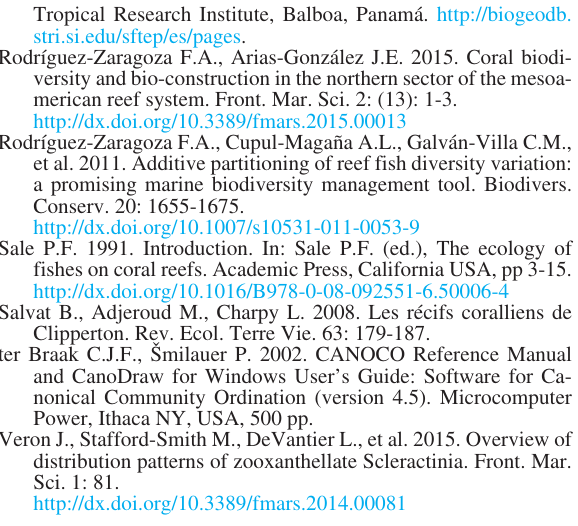
Table S3. – Results of two-way similarity percentage analysis (SIM- PER) of reef fish species biomass found at each depth on the Clipperton